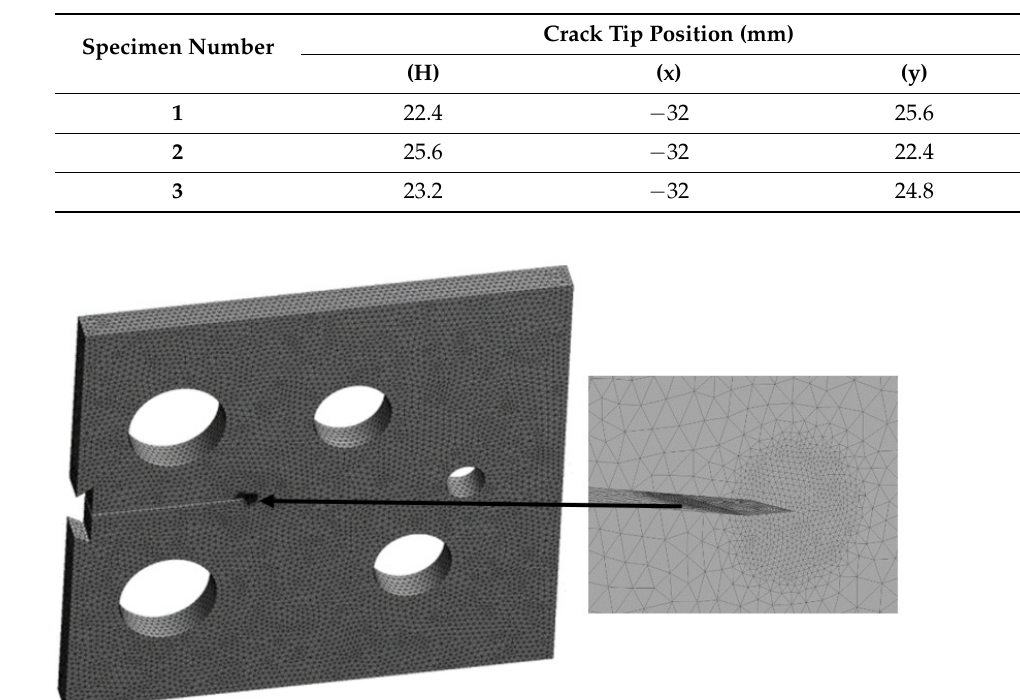
Figure 3. Initial mesh for the modified compact tension. Table 2. Pre-crack position for the modified compact tension.